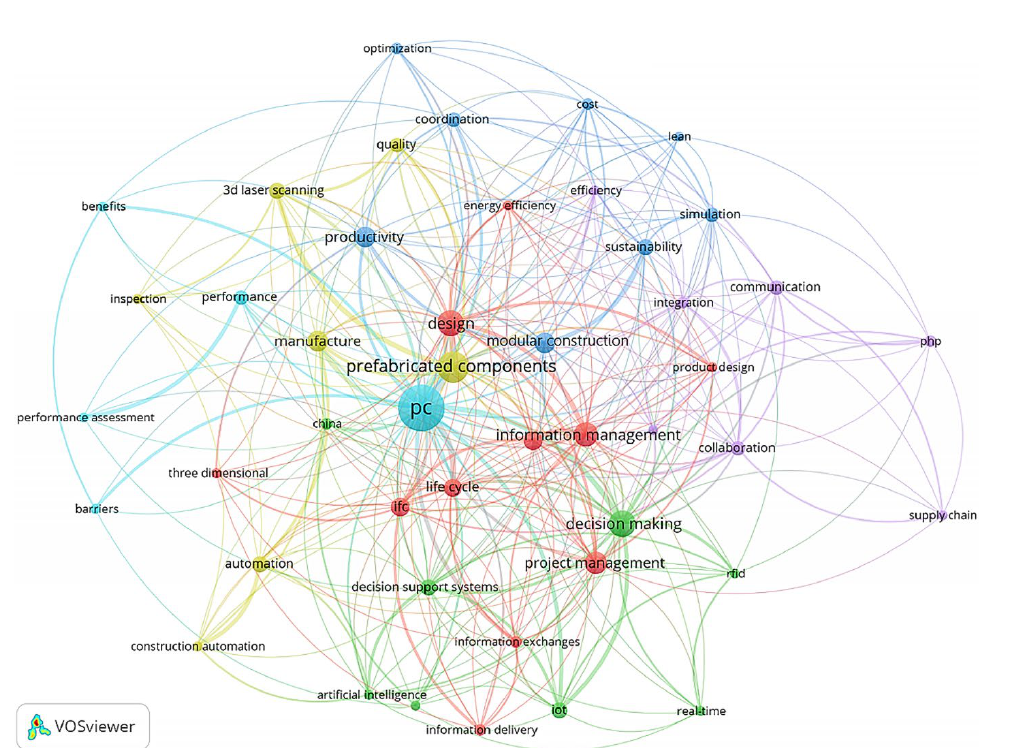
Figure 4. Mapping of co-occurrence keywords in the research of BIM for